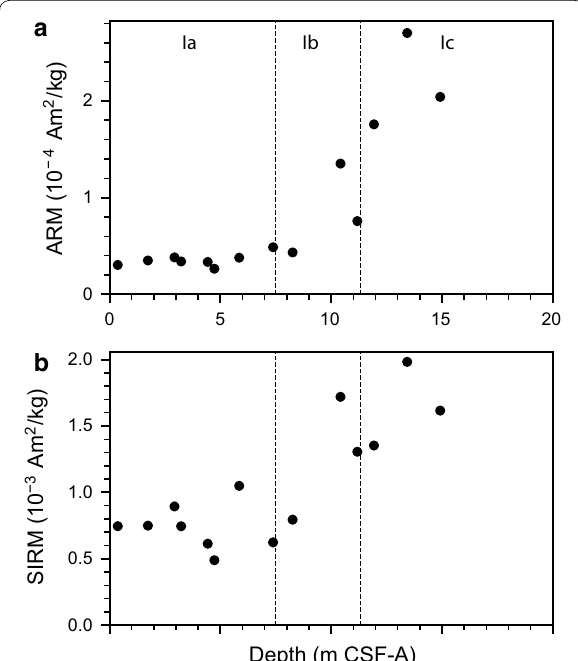
Fig. 5 Depth variation of remanence intensities of quartz and feldspars; ARM ( a ) and SIRM ( b ). Vertical dashed lines represent lithostratigraphic unit boundaries